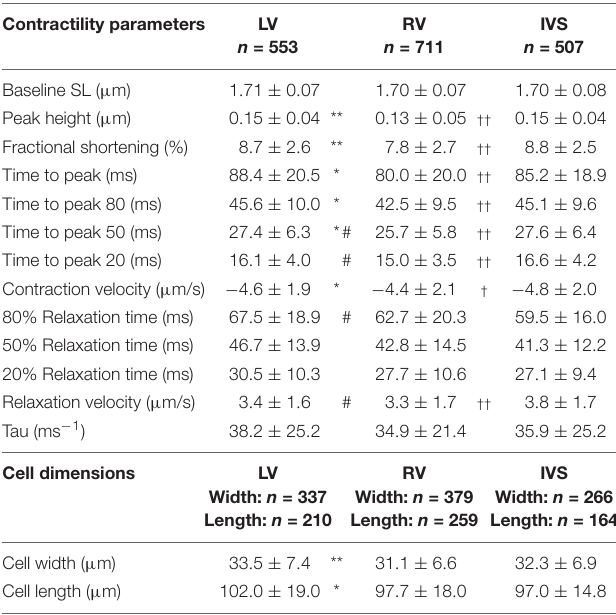
TABLE 2 | Interventricular contractile and cell dimension